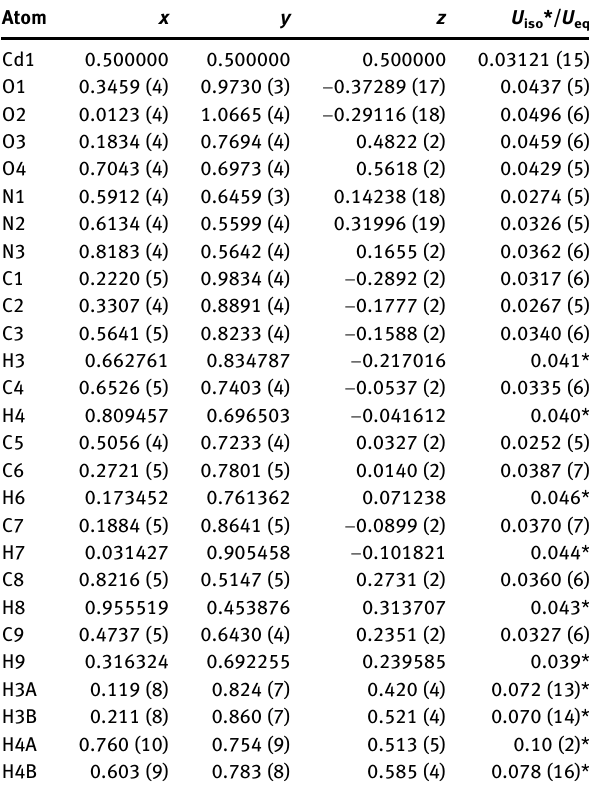
Table  : Fractional atomic coordinates and isotropic or equivalent isotropic displacement parameters (Å 